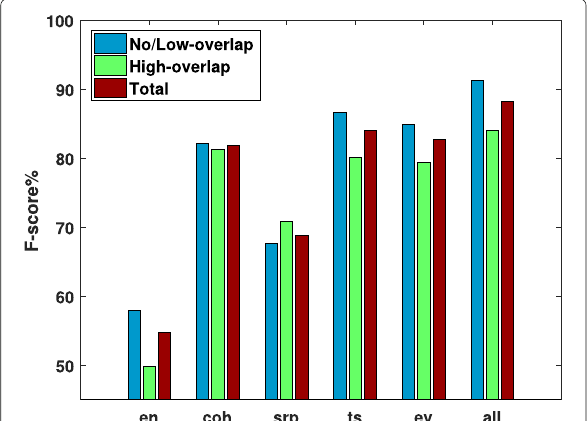
Fig. 11 Performance of the room discriminant features of Section 5.1 in classifying speech segments exhibiting low or high overlap with audioeventsinotherroomsfortheDIRHA-simtest set (en, energy-based; coh, coherence-based; srp, SRP-based; ts, spectrogram texture smoothness; ev, envelope variance; all, intra-room fusion (9)) In all cases, inter-room fusion (10) and room-specific SVMs are